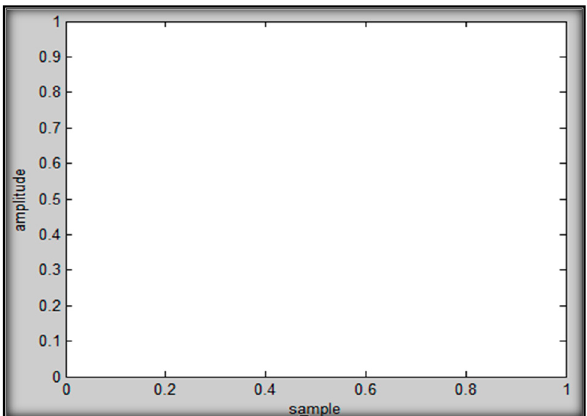
Figure 12. No data received at Rx.